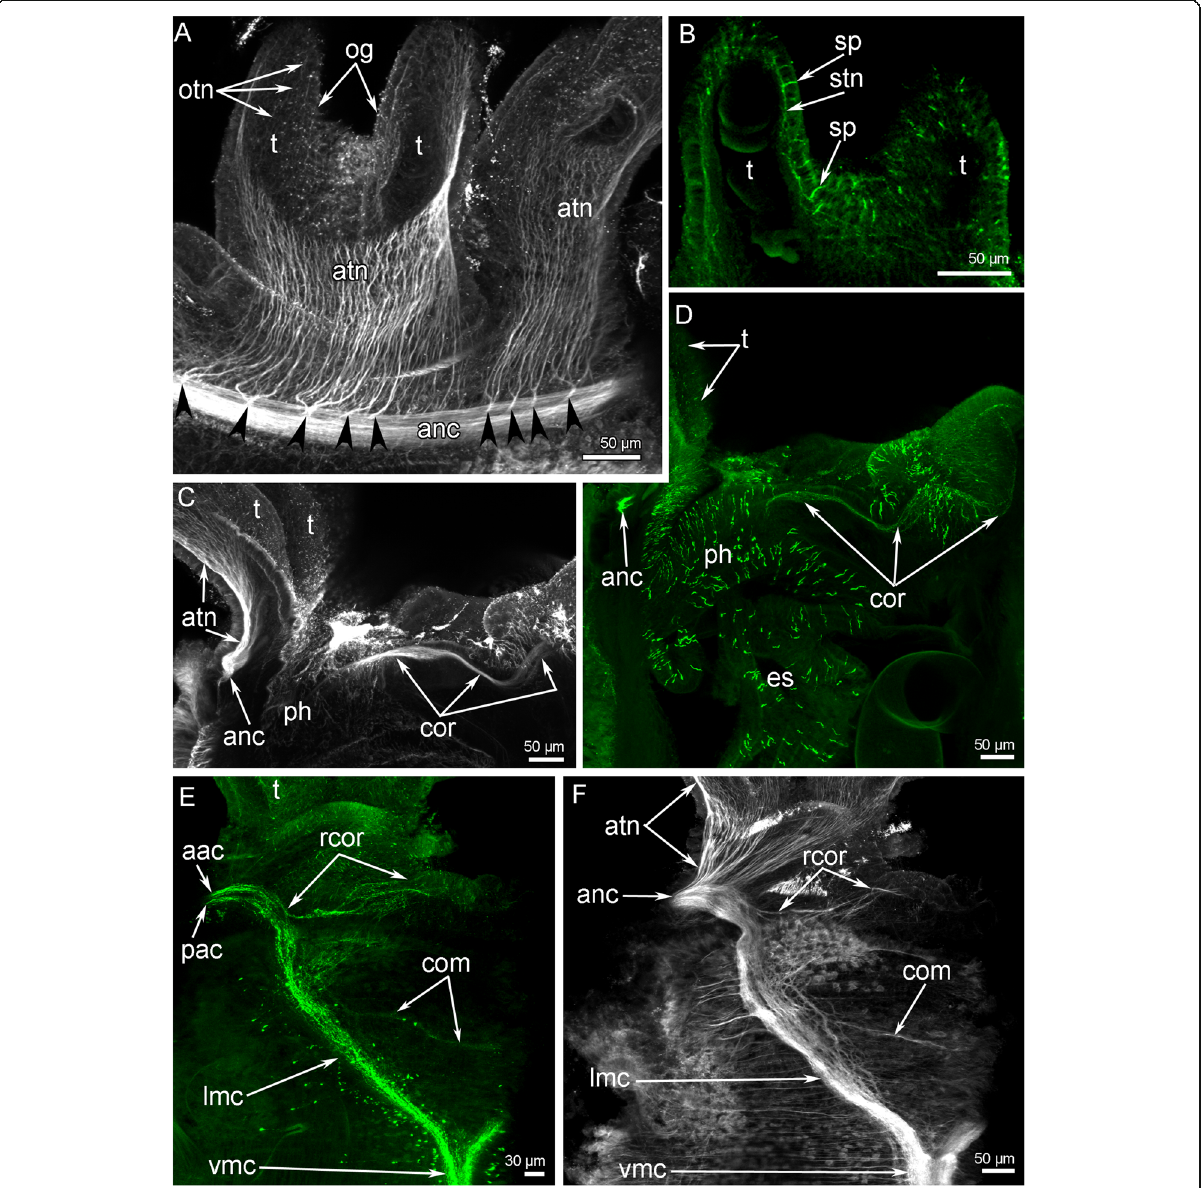
Fig. 9 Details of innervation of tentacle crown and oral area in Owenia borealis . CLSM data: Z-projections after immunostaining against acetylated alpha-tubulin (grey) and serotonin (green). A The aboral side of tentacle base: several short thick nerves (arrowheads) extend from the anterior nerve center and give rise to the oral neurite bundles of tentacles. B Serotonin-lir perikarya and neurites in the epithelium of tentacle. C Central portion of the head: circumoral nerve ring is visible. D Central portion the head: serotonin-lir neurites are visible in the circumoral nerve ring. The epithelium of pharynx contains numerous serotonin-lir cells. E A portion of the head viewed from the ventral side. There are anterior and posterior portions of the anterior nerve center. Right ventrolateral root of the circumoral nerve ring and ventral commissure are visible. F Right portion of the head viewed from the ventral side. Abbreviations: aac – anterior portion of the outer ring of the anterior nerve center; anc – outer ring of the anterior nerve center; atn – aboral tentacle nerves; com – ventral commissure; cor – inner (=circumoral) ring of the anterior nerve center; es – esophagus; lmc – lateral medullary cord; og – oral groove; otn – oral tentacle nerves; pac – posterior portion of the outer ring of the anterior nerve center; ph – pharynx; rcor – root of circumoral nerve ring; sp. – serotonin-lir perikarya; stn – serotonin-lir neurites of tentacles; t – tentacle; vmc – ventral medullary